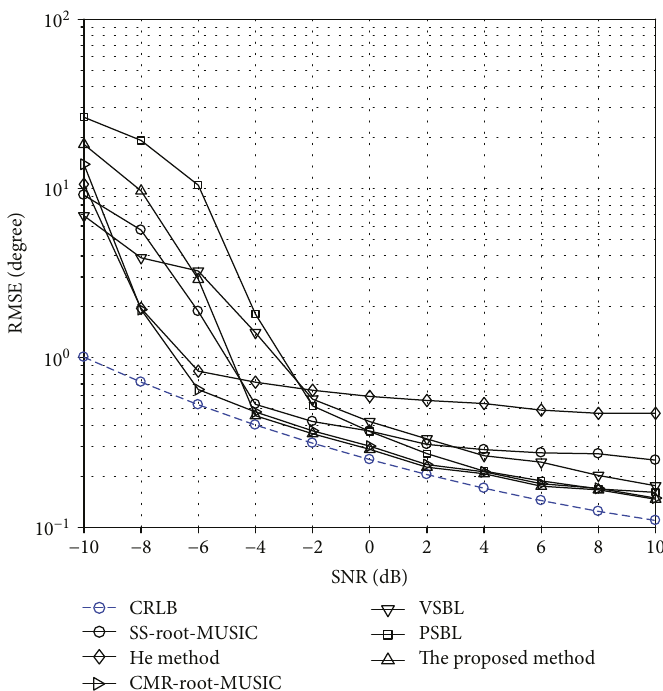
Figure 6: RMSEs of DoA estimation versus SNR for M = 6 , K = 7 , and N = 500